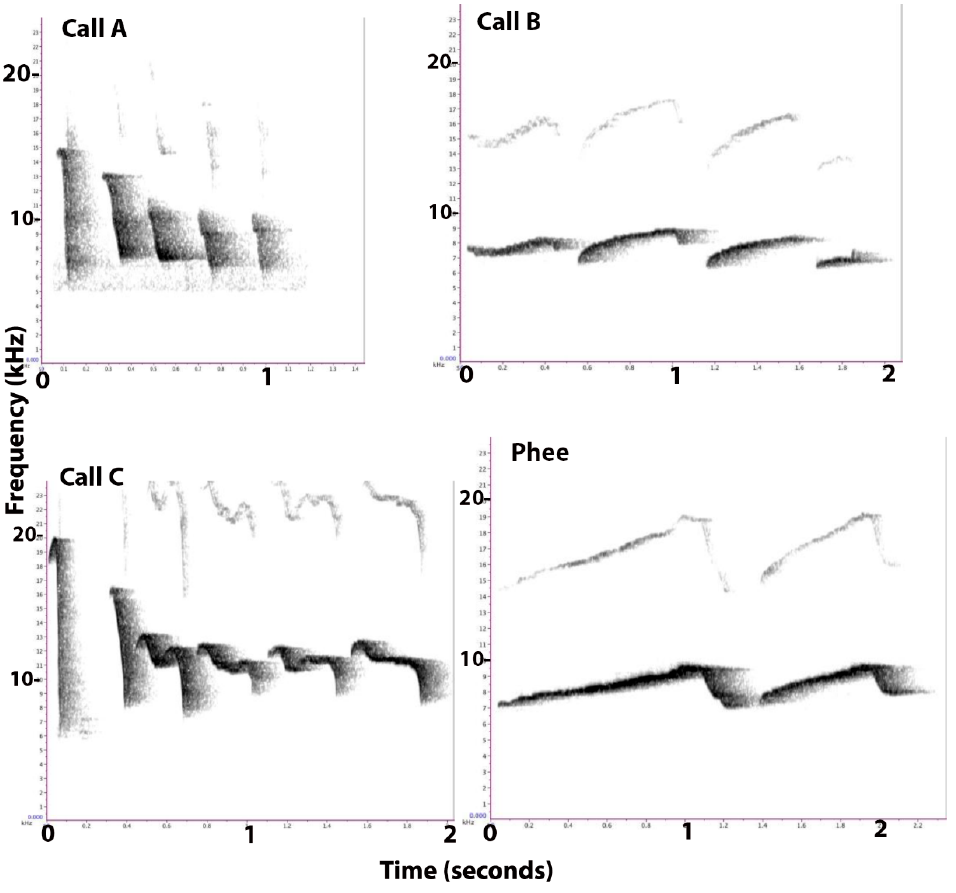
Figure 1. Representative sonograms of Calls A, B, and C, and, for comparison, of a phee call. Frequency in kilohertz (kHz) is plotted on the y -axes and the duration, in seconds, is plotted on the x -axes. Note that the scale differs slightly for each call type.